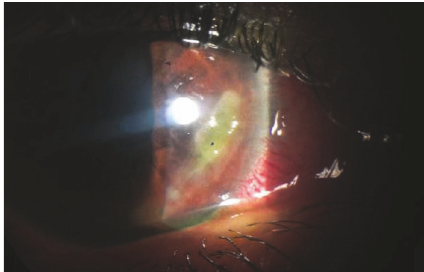
Figure1:Cornealulceratpresentation,ringshapedperipheralulcer from 3 to 6 o’clock, sparing the limbus.